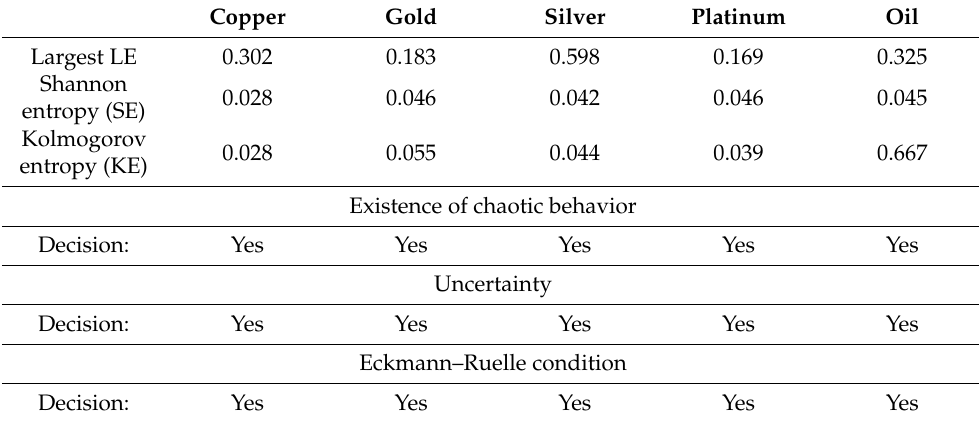
Table 4. The results of Lyapunov exponent, and Kolmogorov and Shannon entropy testing.